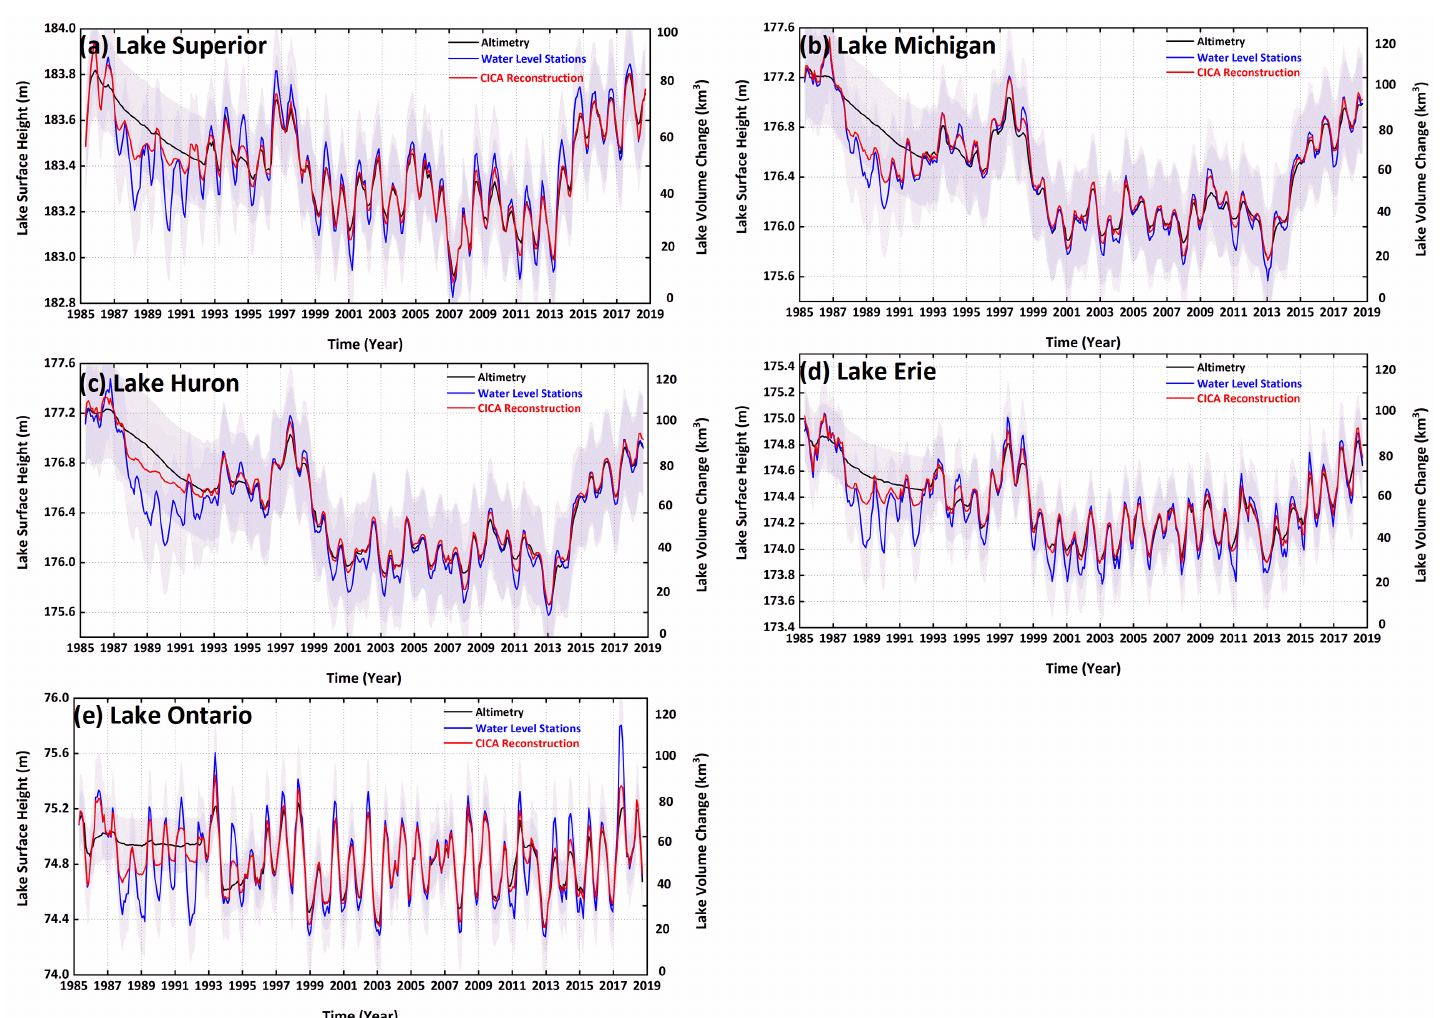
Figure 6. Time series of lake surface height in each lake of the Great Lakes from altimetry data (black line), water level stations (blue line), and CICA reconstruction (red line).